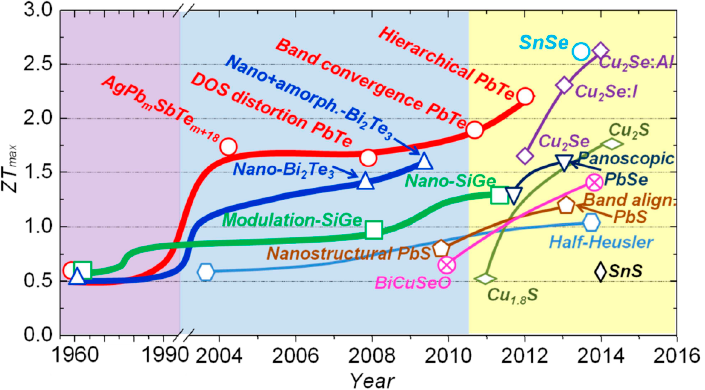
Figure 19. Chronological progress of the FoM ZT for different TE materials [147].